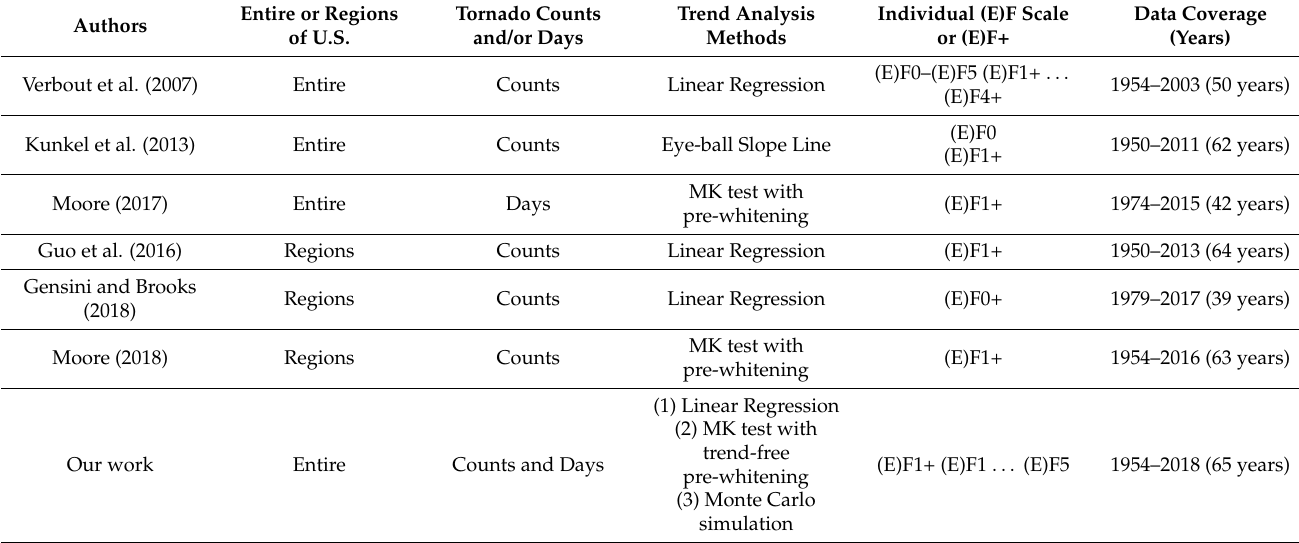
Table 2. Comparisons of trend analysis for U. S. tornado